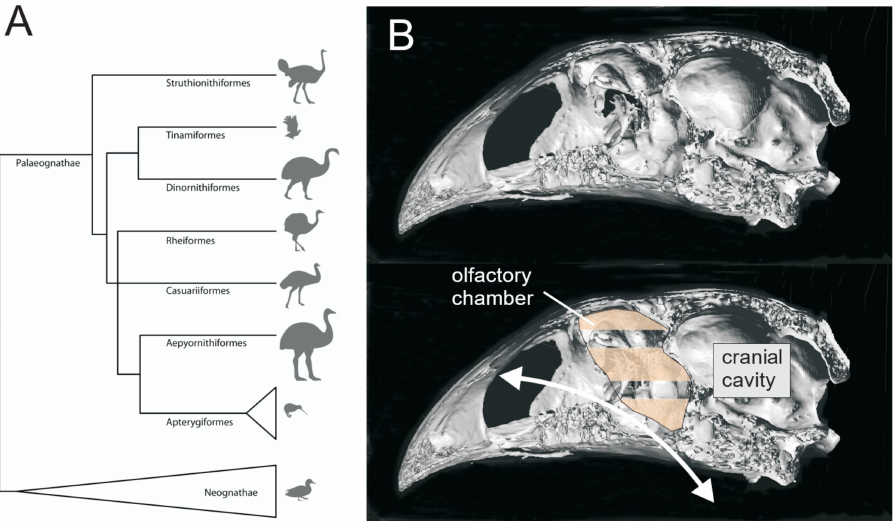
Figure 1. ( A ) phylogenetic tree indicating relationships of palaeognathous birds. ( B ) Pachyornis elephantopus , mid-sagittal skull reconstruction, showing nasal air passage (arrow), olfactory chamber, and cranial